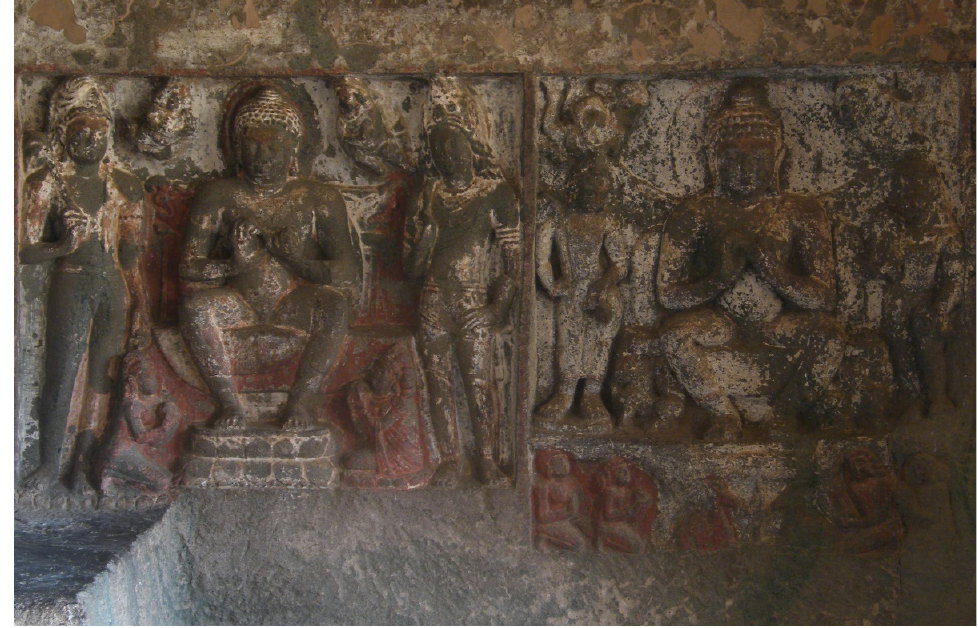
Figure 5. Intrusive panels from Aja ṇṭ ā Cave 11, ca. 478–480 CE (Photograph by the